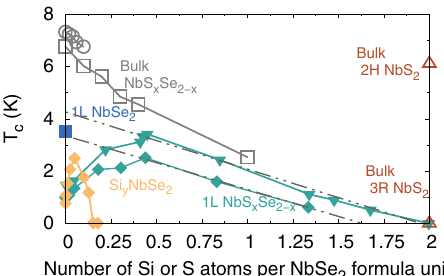
Fig. 1 Experimental reports of the superconducting transition temperature versus alloy concentration. Data is for bulk and ML NbS x Se 2 − x alloys as a function of S content, x and Si content, y . The references associated with each marker is as follows: gray open squares 16 , gray circles 15 , teal and orange fi lled downward triangles and diamonds 12 , red triangles 10 and blue fi lled square 1 . Open symbols correspond to measurements on bulk samples while fi lled symbols correspond to measurements on ML samples. The dotted lines correspond to a linear extrapolation of the ML data for x > 0.4. See the main text for the discussion on the